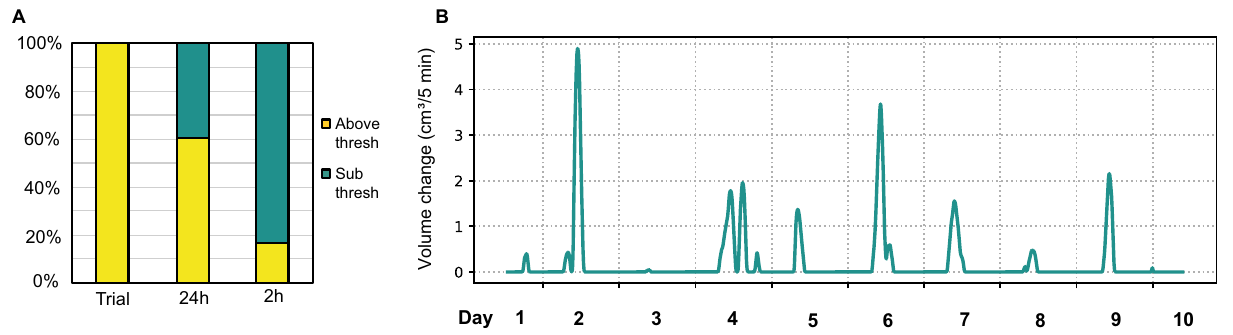
Figure 5. Bowers are constructed through punctuated bursts of activity. Following thresholding, all bower trials exhibited above threshold volume change. At shorter timescales, 60.6% of all 24-h bins analyzed and 16.7% of all 2-h bins analyzed contained above threshold depth change ( A ). Analysis of rolling hourly depth change in five-minute increments over the course of whole trials reveals that structural change is driven by relatively brief bursts of activity punctuated throughout trials (representative Mchenga conophoros trial, ( B